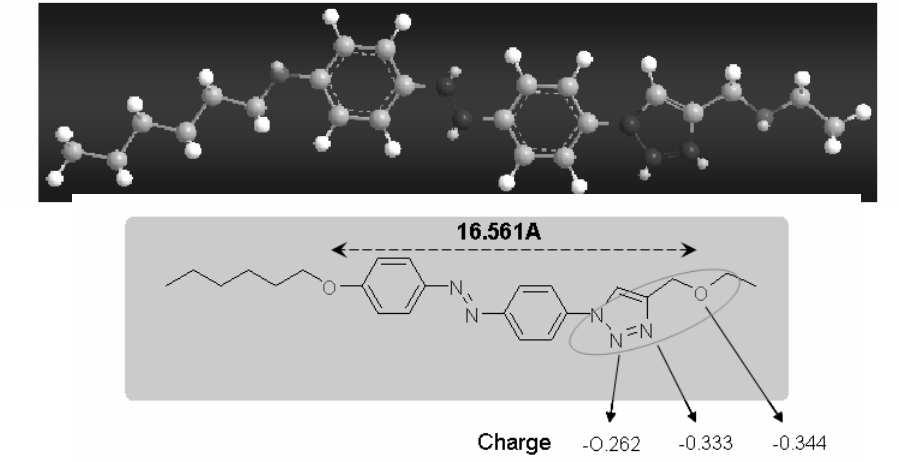
Figure 3. Energy minimized structure of the model